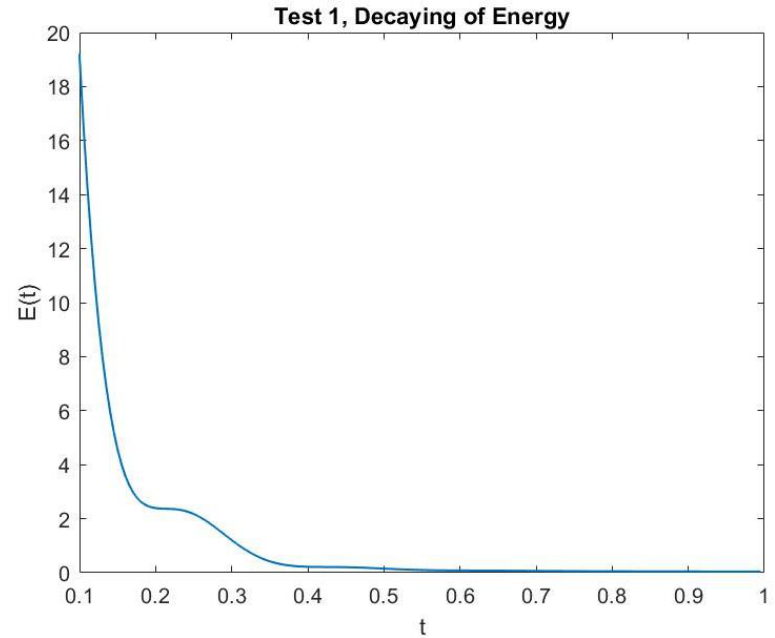
Figure 3. Test 1: The energy decay.